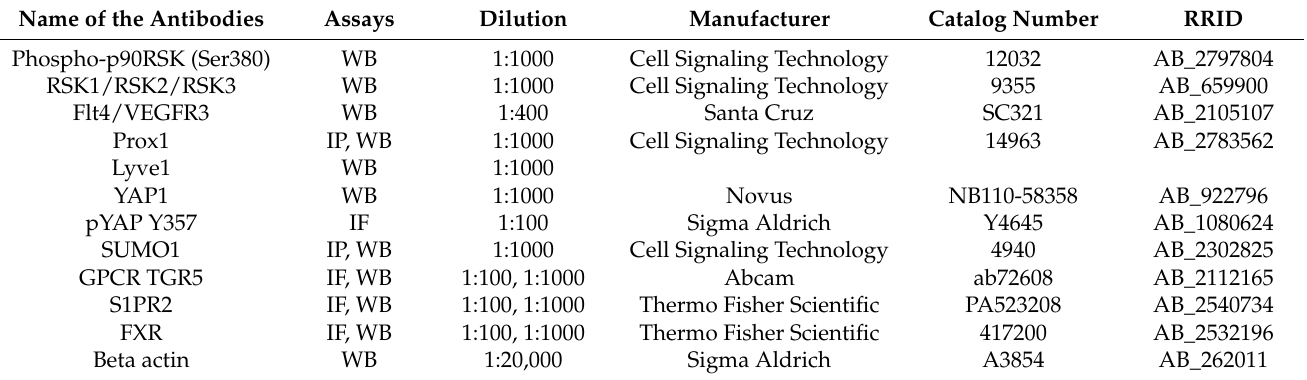
Table 2. Antibodies used in Western blot, immunohistochemistry, and